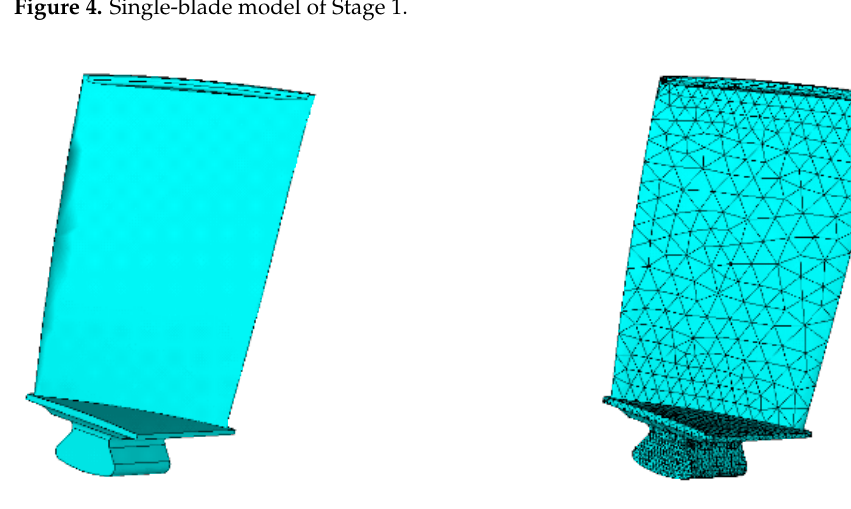
Figure 5. Single-blade model of Stage 2.